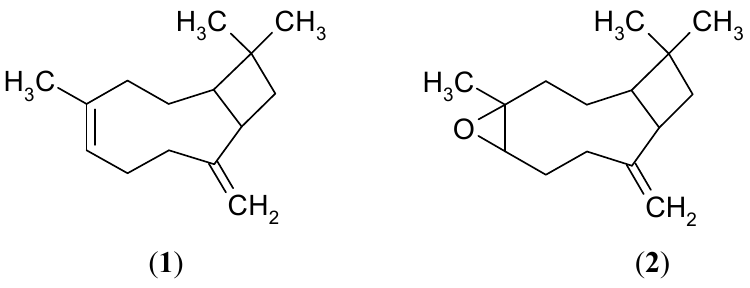
Figure 2. Structures of β -caryophyllene ( 1 ), and caryophyllene oxide ( 2